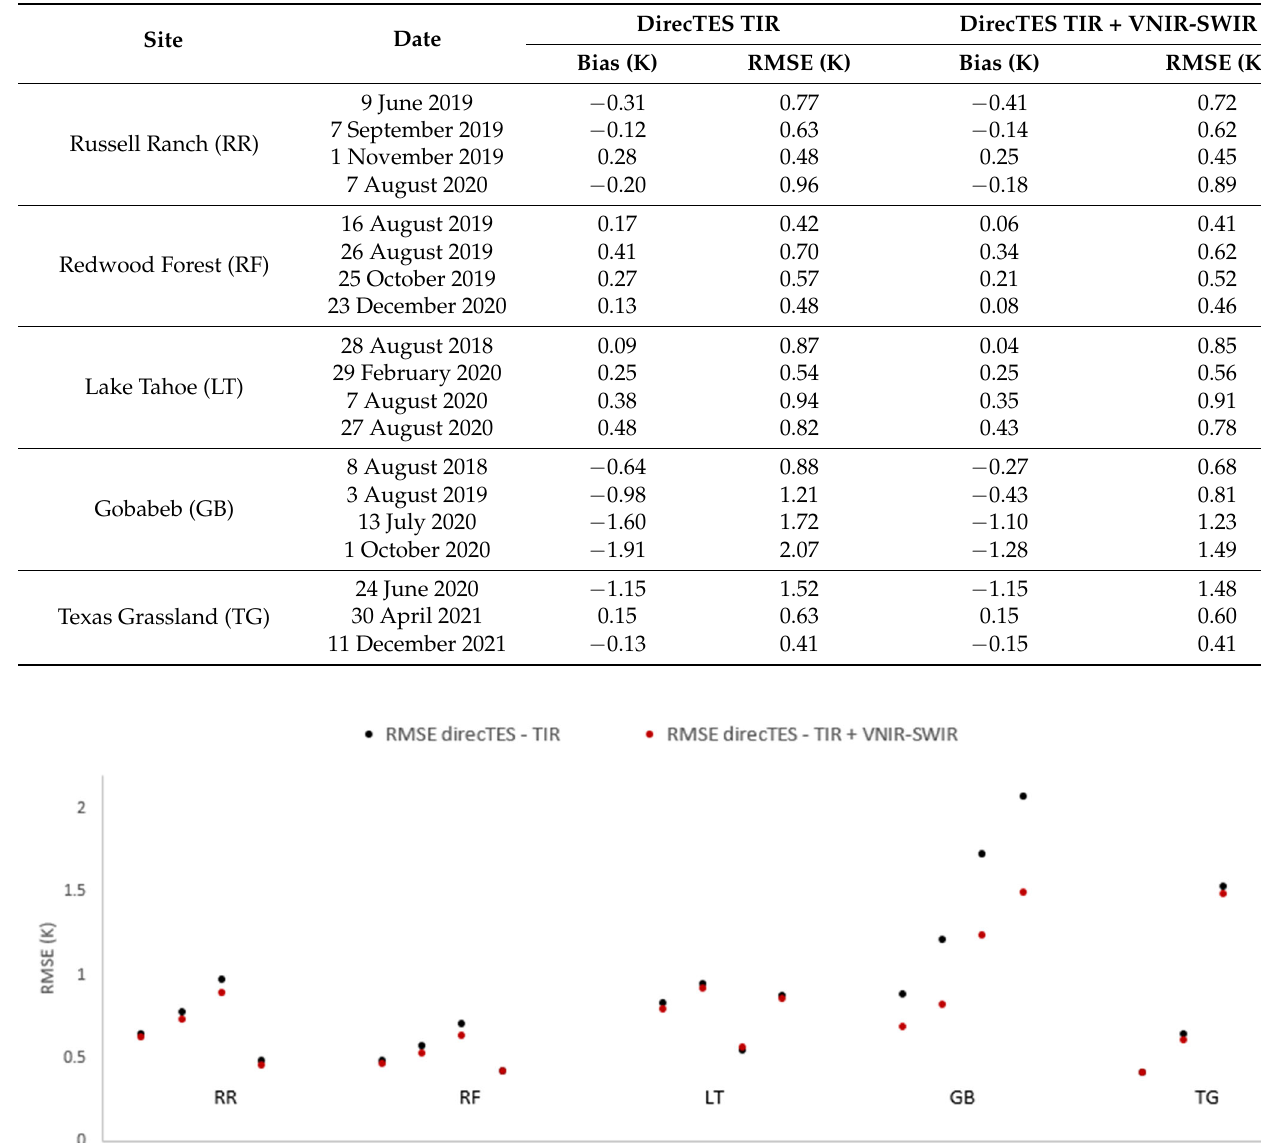
Table 5. Bias and RMSE of DirecTES LST retrievals compared with ECOSTRESS LST on the whole images containing the selected instrument sites.